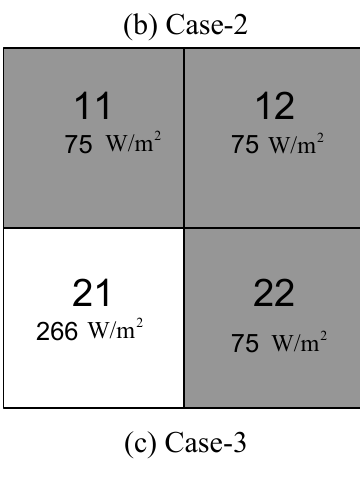
Figure 5. Shadow test cases for performance evaluation